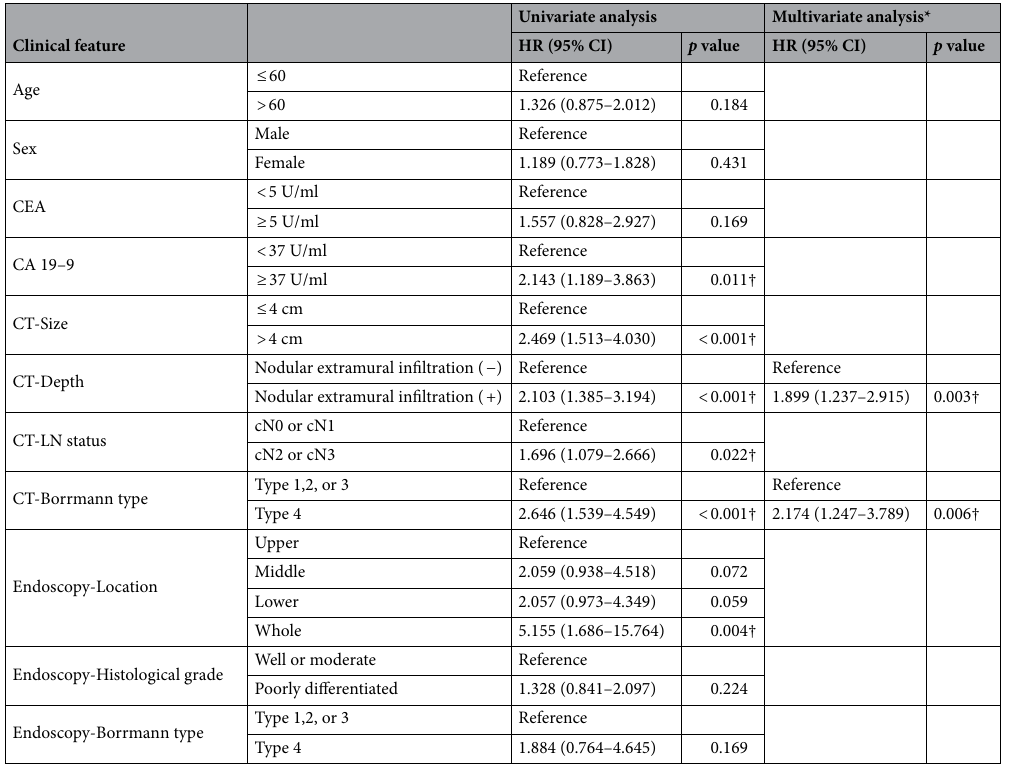
Table 2. Preoperative clinical factors for predicting tumor recurrence-free survival. HR, hazard ratio; CI, confidence interval; CEA, carcinoembryonic antigen; CA, carbohydrate antigen. *The multivariate regression model was built using backward stepwise approach with Akaike information criteria. † Statistically